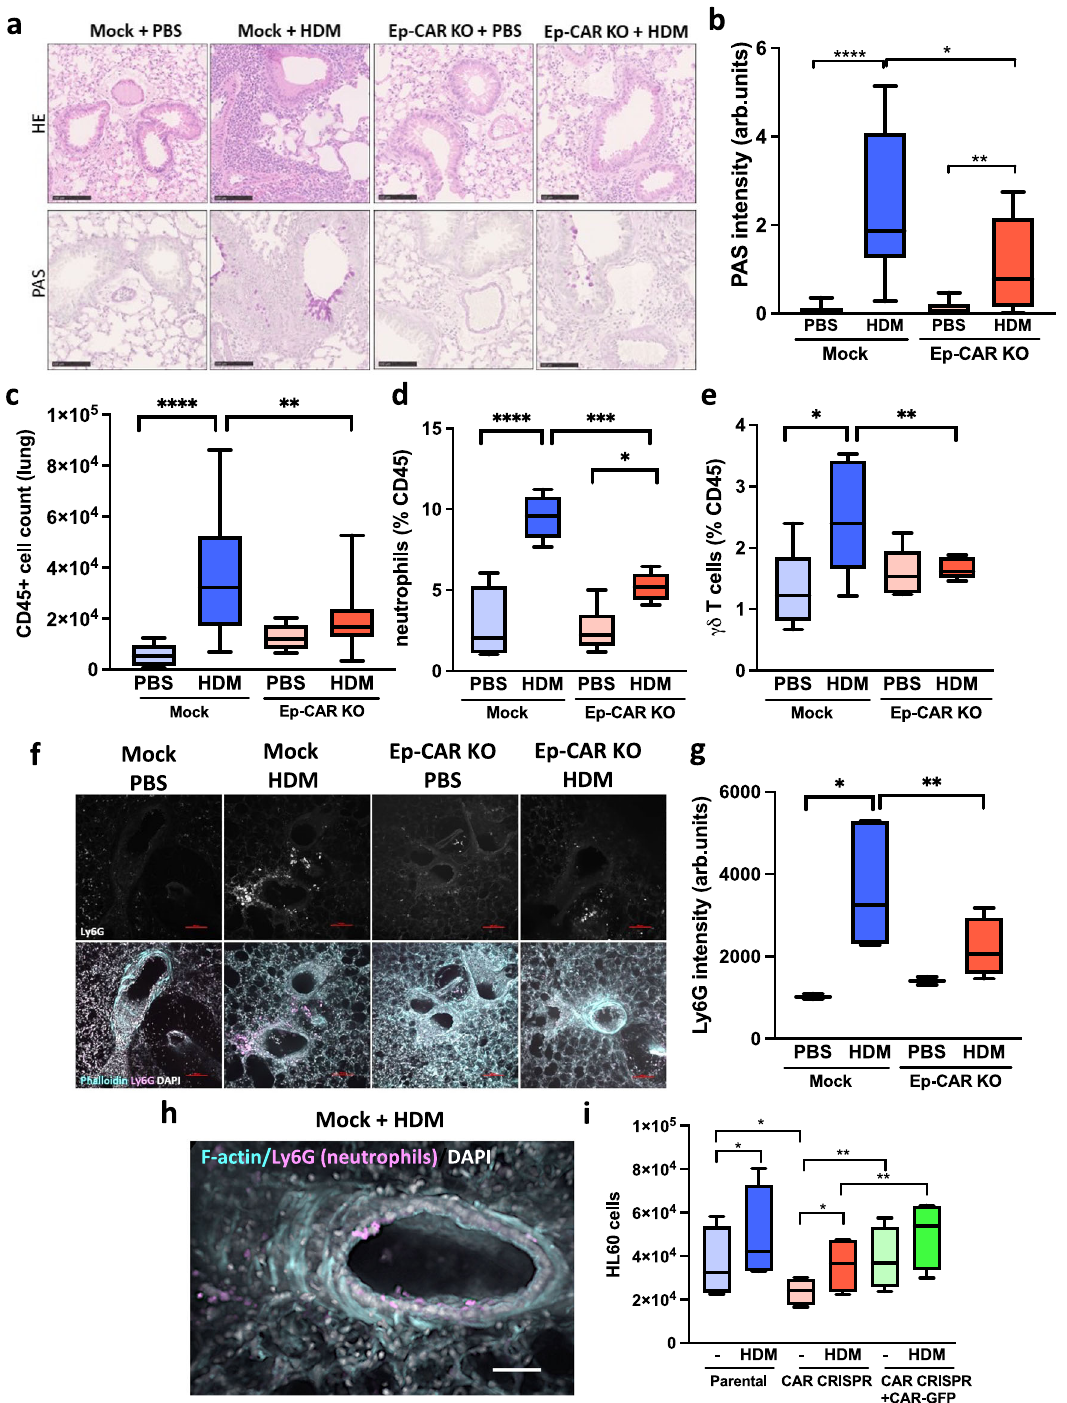
Fig.1|CARpromoteslungin fl ammationinresponsetohousedustmite(HDM). a Representative images of H&E (top) and Periodic Acid-Schiff Staining (PAS; bottom) of FFPE lung sections from indicated animals and conditions. Scale bars 100 μ m. b Quanti fi cationof PAS staining from 5 mice per group. For each mouse, one lobe was collected for PAS staining, and 6 airways/mouse analysed; repre- sents 3 independent experiments c CD45 + positive cells in lung homogenates from indicated conditions. d % of LYC6G+ve neutrophils and e % of γδ Τ cells in CD45 + positive population in lung homogenates. For c – e , data is from one lobe per mouse, from 5 mice; representative of 3 independent experiments. f Representative confocal Z-projection of Precision Lung Cut Slices (PCLS). Ly6G staining (upper panels), and merged images shown (actin=cyan; Ly6G=